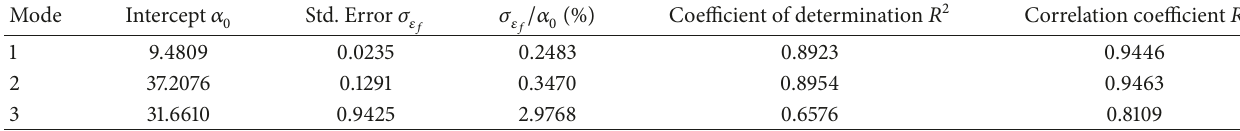
Table 8: Coefficients of linear regression model (frequency ∼ temperature + humidity) of girder No. 1.